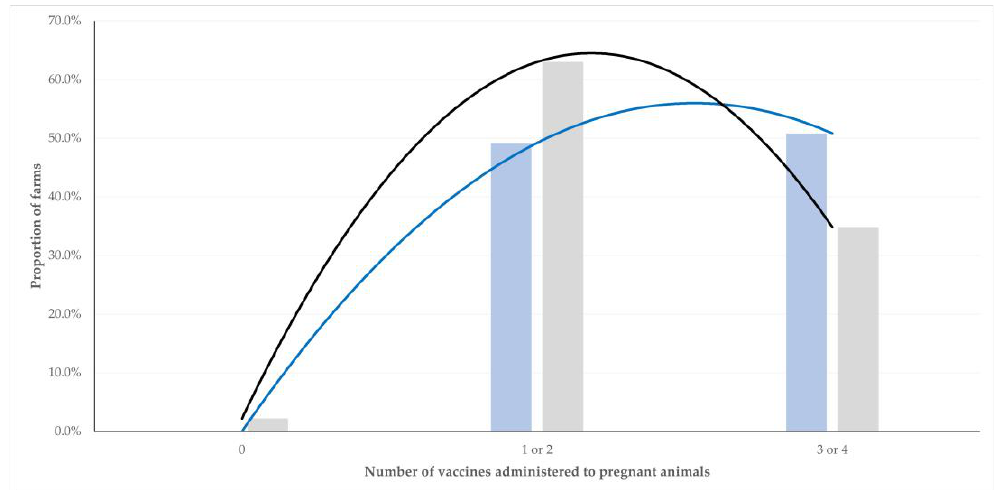
Figure 3. Proportions of small ruminant farms (sheep flocks and goat herds cumulatively) in Greece, in which reproductive control was (blue) or was not (gray) applied, in accord with the number of vaccines administered to animals during pregnancy ( p = 0.006) (solid lines indicate respective trend-lines).